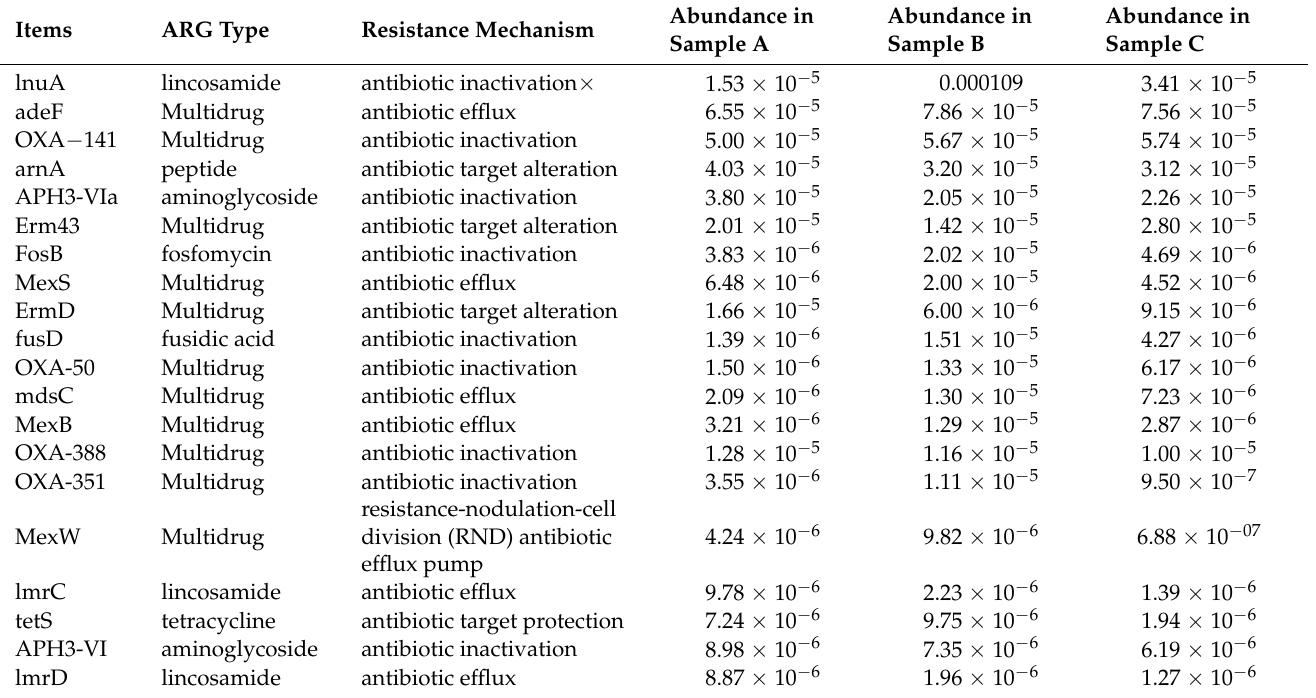
Table 1. Representative ARG subtypes and their abundance in each